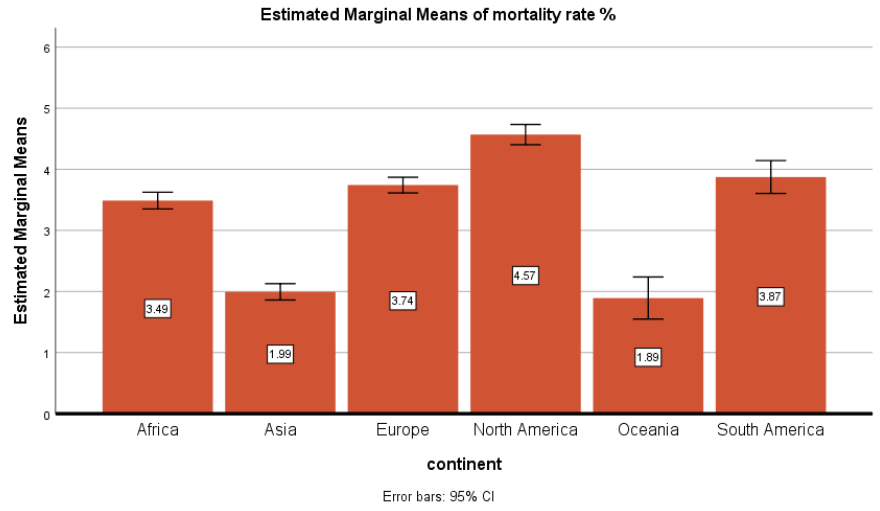
Figure 4. Mortality rate in percentage by continent.